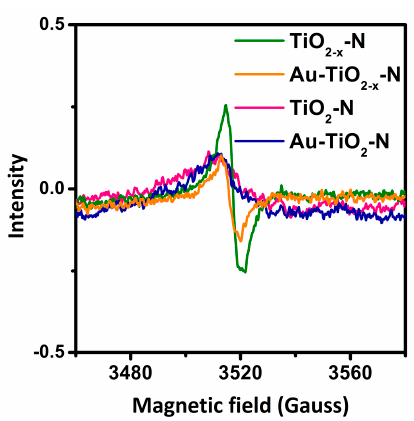
Figure 6 The electron paramagnetic resonance (EPR) spectra of various TiO 2 supports and Au ‐ TiO 2